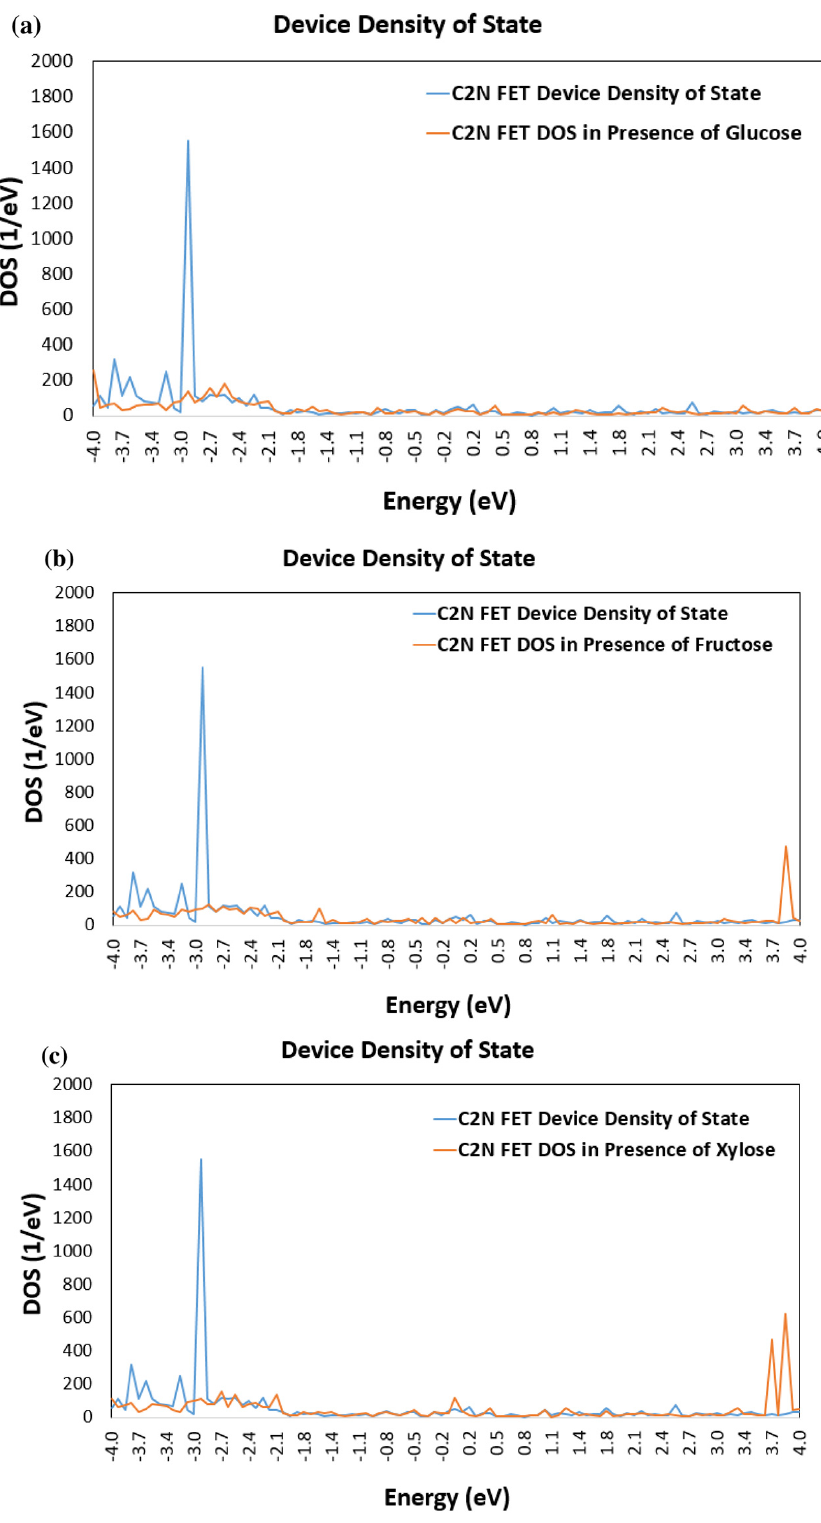
Figure 4. Change in device density of states (DOS) of simulated C 2 N FET in presence of ( a ) glucose molecule; ( b ) fructose molecule; and ( c ) xylose molecule.